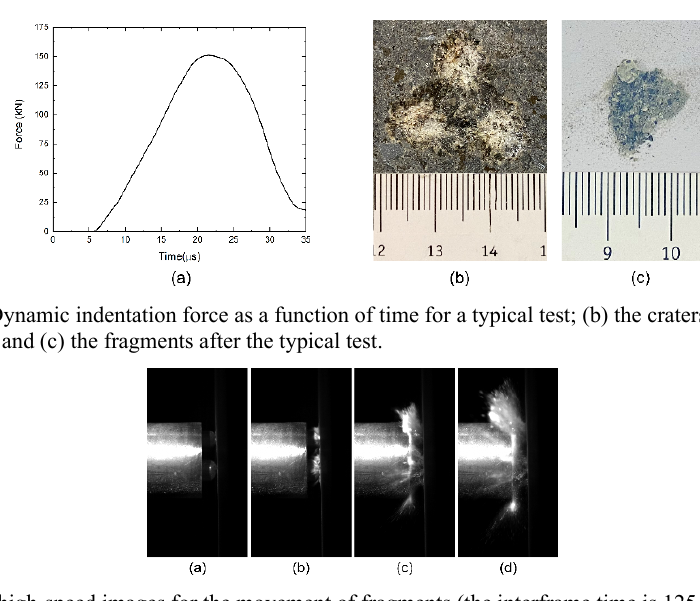
Fig. 7. The high-speed images for the movement of fragments (the interframe time is 125 µs).